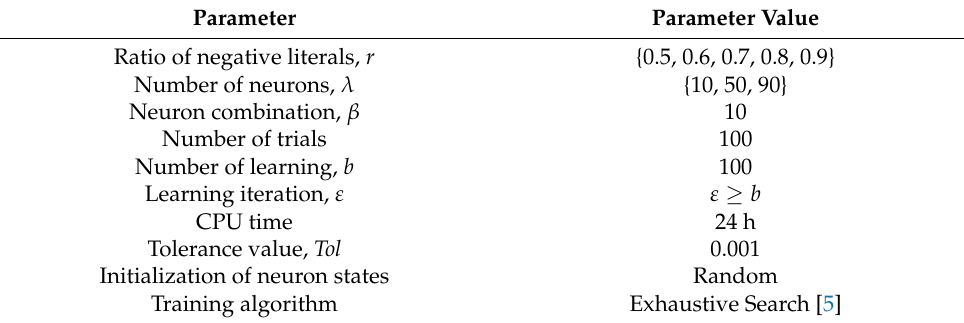
Table 2. List of Parameters used in DHNN model.